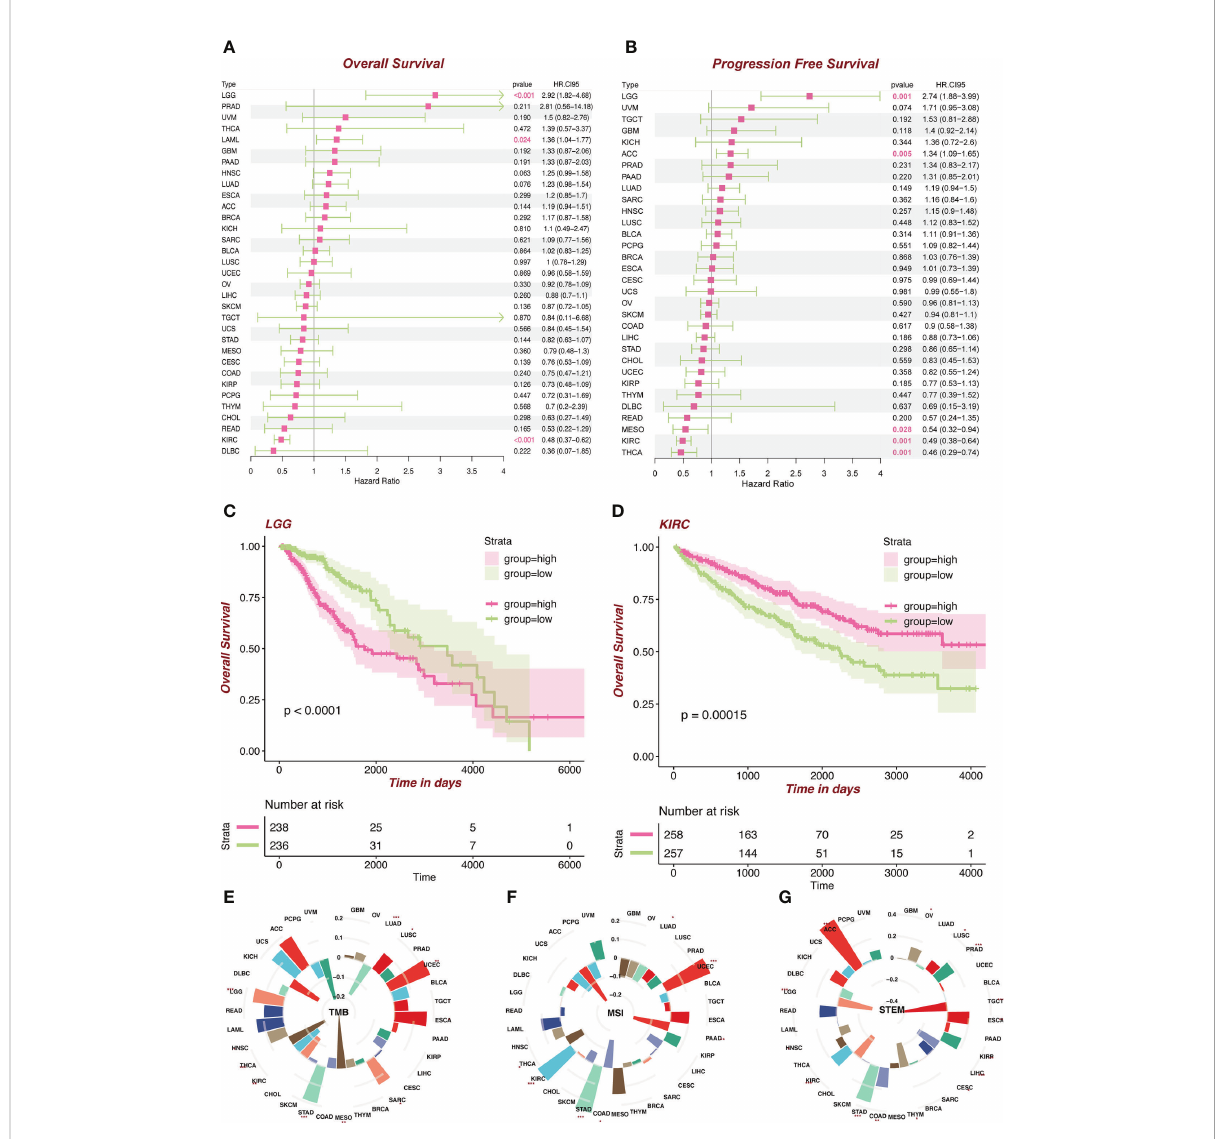
FIGURE 3 Survival analysis of FDX1 in tumors and TMB, MSI, and stemness analysis of FDX1 . (A) Overall survival in different tumors based on the FDX1 expression 50% cutoff grouping. (B) Progression-free survival in different tumors based on the FDX1 expression 50% cutoff grouping. (C, D) The Kaplan – Meier plot of LGG and KIRC based on the FDX1 expression 50% cutoff grouping. (E – G) Tumor mutant burden (TMB), microsatellite instability (MSI), and stemness analysis of FDX1. ns, not signi fi cant, p ≥ 0.05; *p < 0.05; **p < 0.01; ***p <